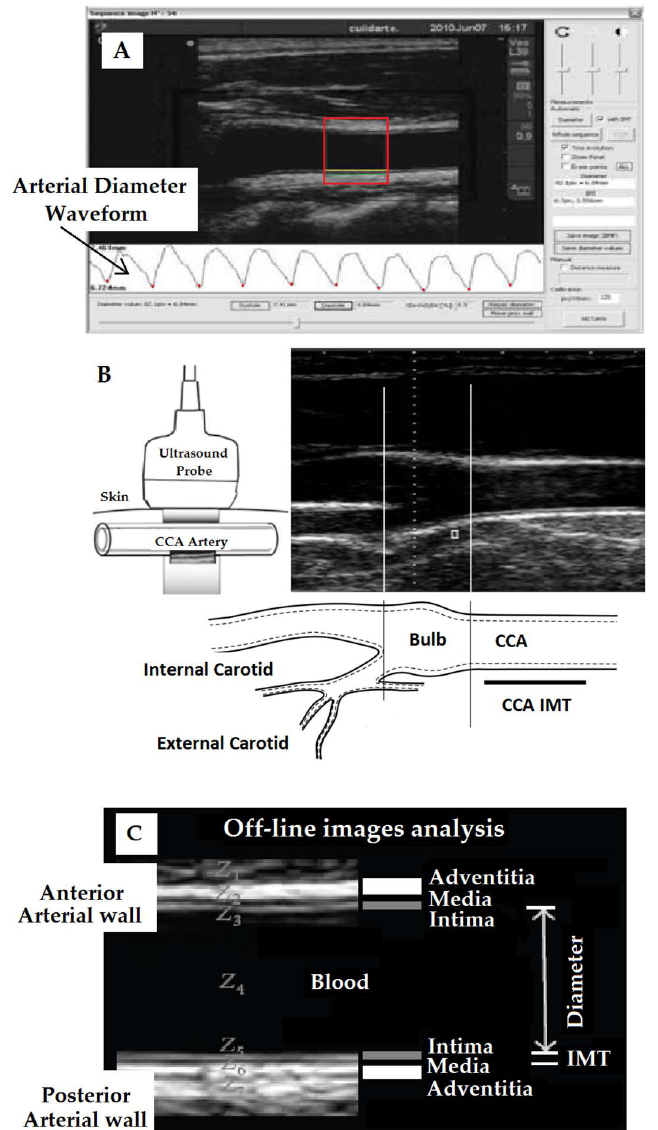
Figure 1. ( A ): Software for intima–media thickness (IMT) and diameter measurement (Hemodyn- 4M). Red box: region of interest (ROI) to quantify diameter and IMT. ( B , C ): Methodological approach used to assess common carotid (CCA) and femoral artery (CFA) diameter and intima–media thickness (IMT). Z: acoustic impedance. IMT is defined as a double-line pattern visualized by echo 2D on both arterial walls in longitudinal views. Two parallel lines (leading edges of anatomical boundaries) form lumen–intima and media–adventitia interfaces. Modified from [4].